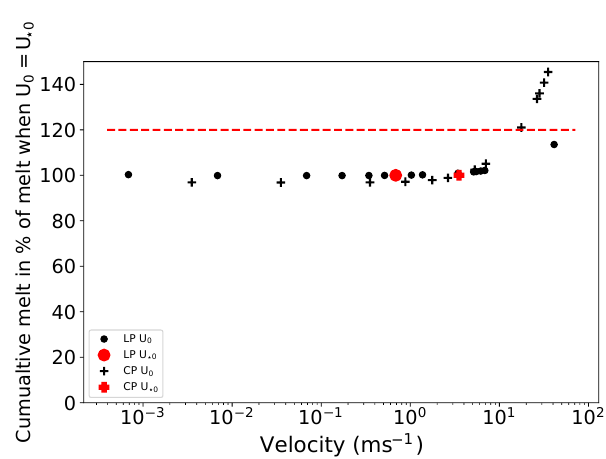
Figure 3. Sensitivity of cumulative melt rate to different initial ve- locities for both plume models. Melt rate (black) is in percent of the cumulative melt achieved with initial balance velocity U (cid:63) 0 (red). Red dashed line shows 120% mark. Only very high initial veloci- ties can appreciably increase the cumulative melt rate for the CP.